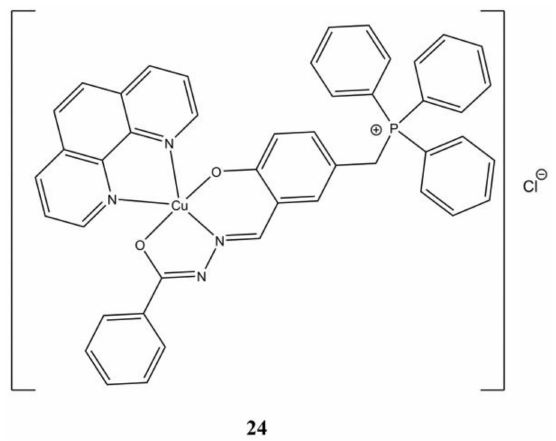
Figure 24. Structure of the [Cu(phen)(L3)]Cl